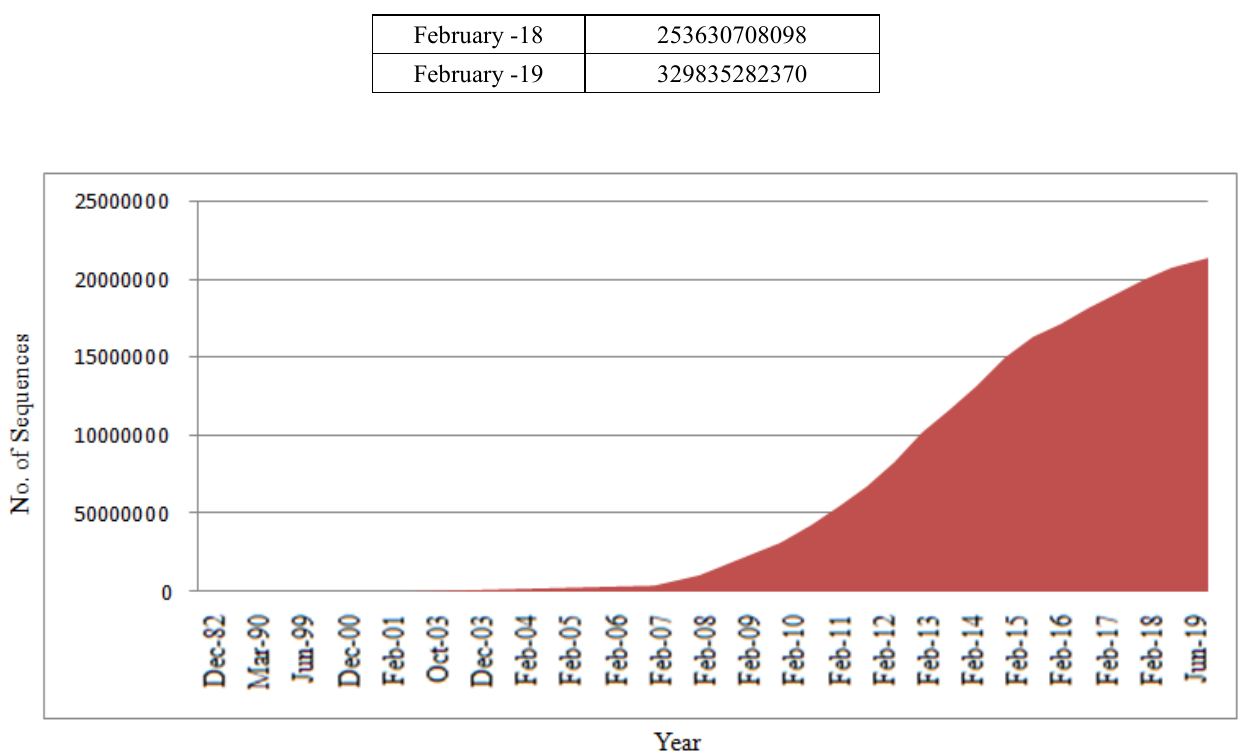
Figure 2. The Exponential Growth of Genetic Sequences in the GenBank Database Source -http://www.ncbi.nlm.nih.gov/genbank/statistics Table 2. The Exponential Growth of Genetic Sequences in the GenBank